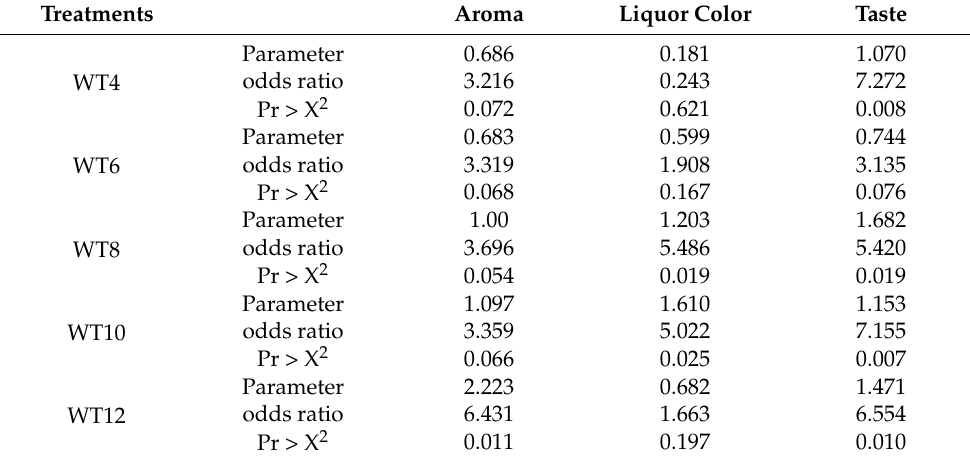
Table 2. Parameter estimates, probability, and odds ratio